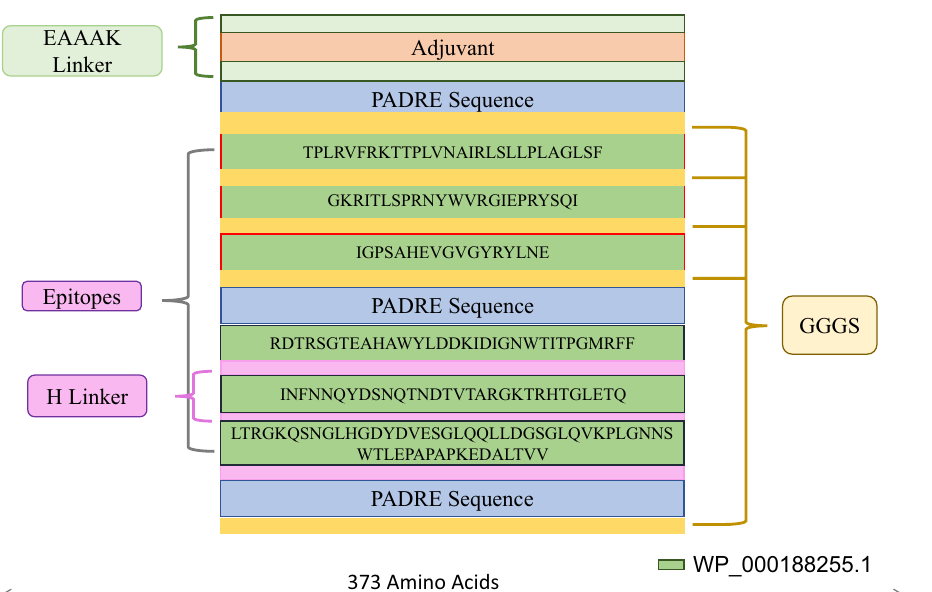
Figure 5. Schematic presentation of the final multi-epitope vaccine peptide. The 373 amino acid long peptide sequence containing adjuvant (brown) at both N and C terminal was linked with the multi-epitope sequence through an EAAAK linker (green). GGGS linkers (yellow) while the peptiope epitopes are linked with GGGS linkers (dark